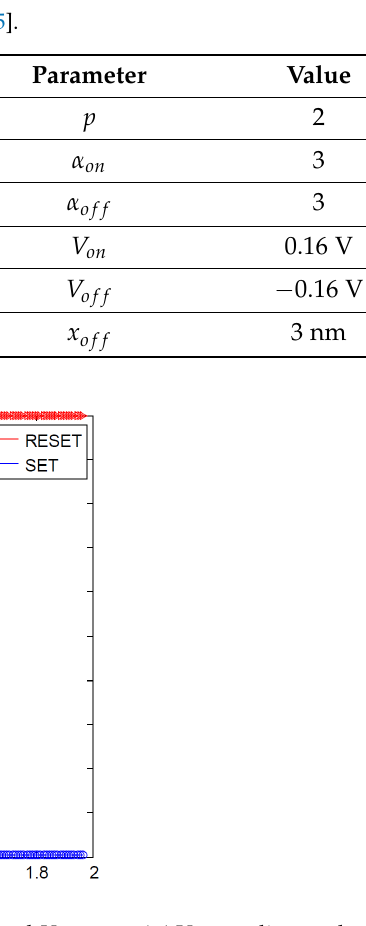
Figure 11. Memristor switching time for V set = 1.4 V and V reset = − 1.4 V according to the device in